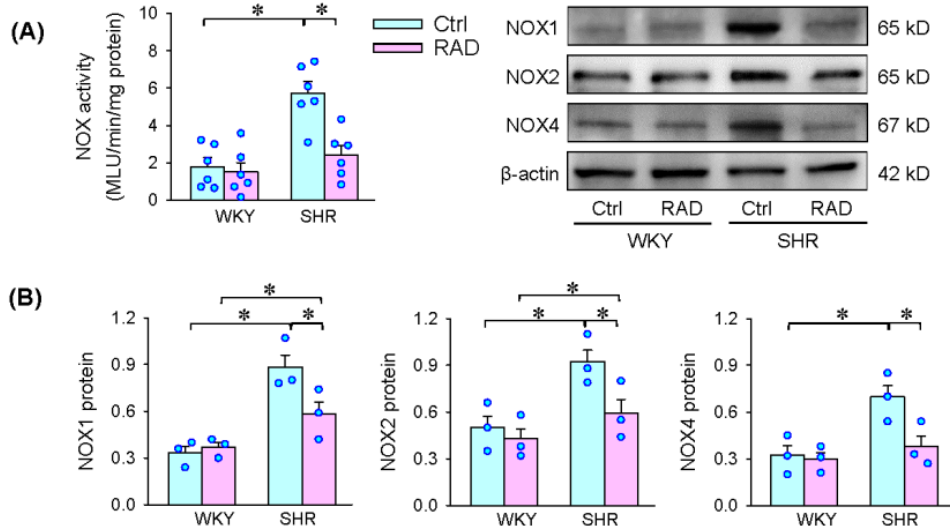
Figure 5. Effects of RAD on NOX activity and expression in the PVN of WKY and SHR. ( A ) NOX activity. ( B ) NOX1, NOX2 and NOX4 protein expressions. Values are mean ± SE. Two-way ANOVA followed by Bonferroni’s post hoc analysis were used for comparisons. * p < 0.05. n = 6 for each group in A; n = 3 for each group in